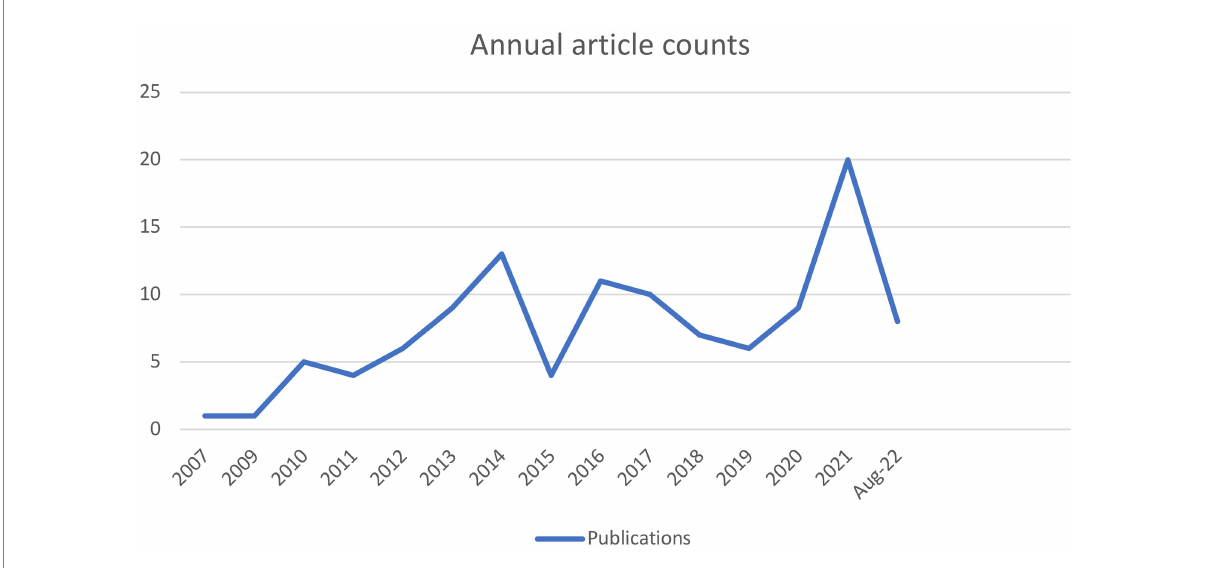
FIGURE 3 Annual article counts.